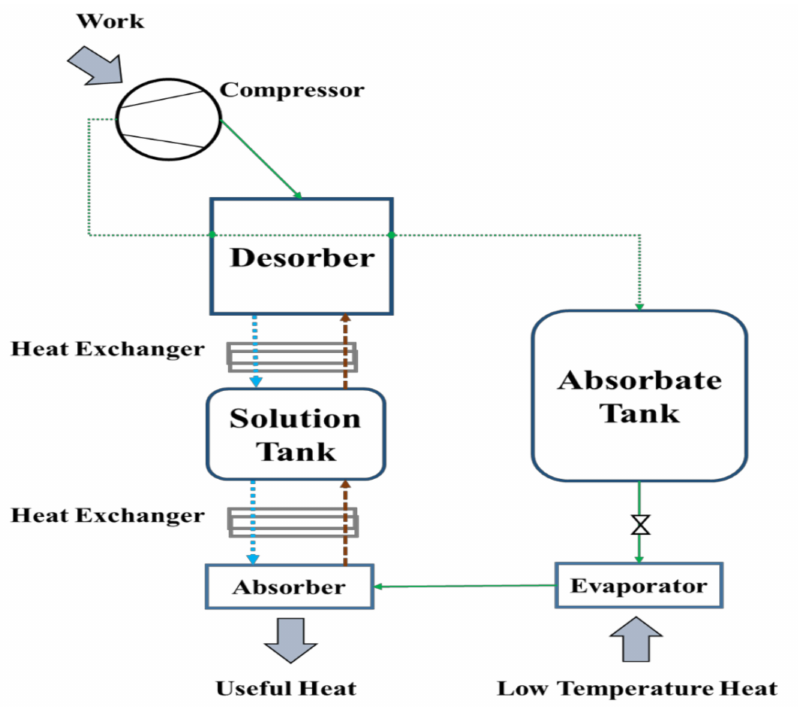
Figure 14. Compression-driven absorption cycle integrated with thermal storage